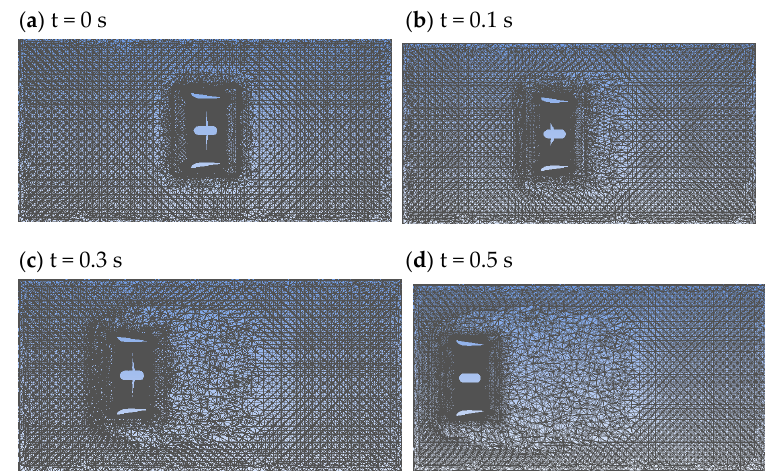
Figure 8. Mesh update process. ( a ) t = 0 s; ( b ) t = 0.1 s; ( c ) t = 0.3 s; ( d ) t = 0.5 s.